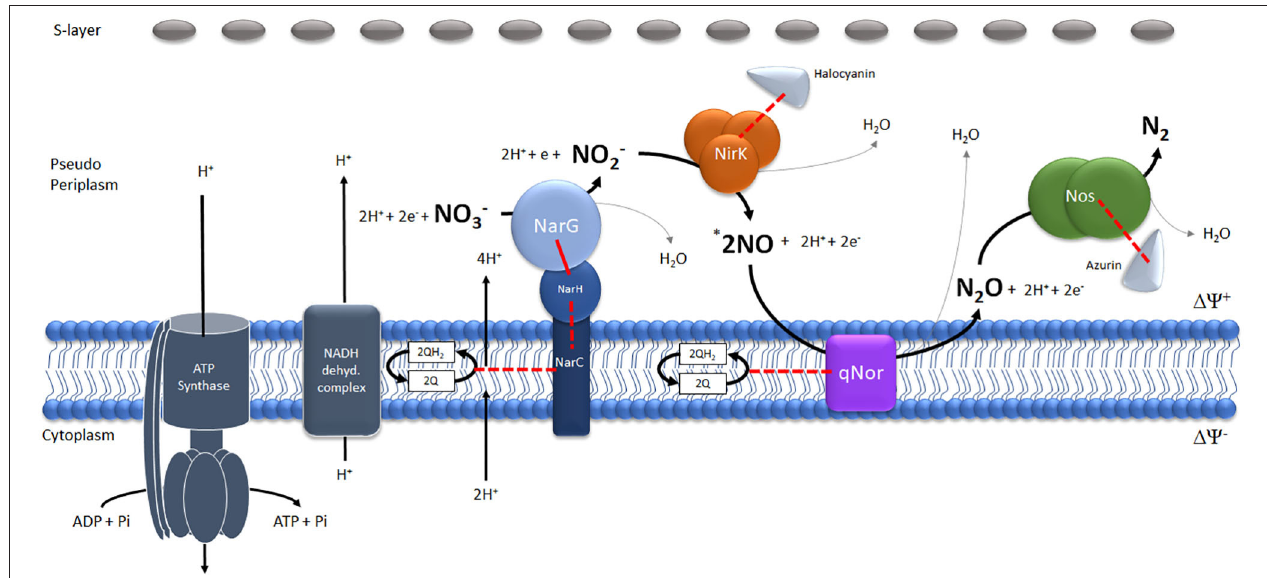
FIGURE 3 | Schematic model of the potential denitrification super-complex in Haloferax mediterranei. The different reactions catalyzed by the four enzymes (Nitrate-Nar, Nitrite-Nir, Nitric oxide-Nor and Nitrous oxide- Nos reductases) have been represented stoichiometrically. *The number of NO molecules generated by the reduction of one molecule of NO − 2 has been multiplied by two to maintain the stoichiometry of the generation of one molecule of N 2 O.The red lines represent physiologically tested (continuous lines) or potential(discontinuous lines) electron flows.